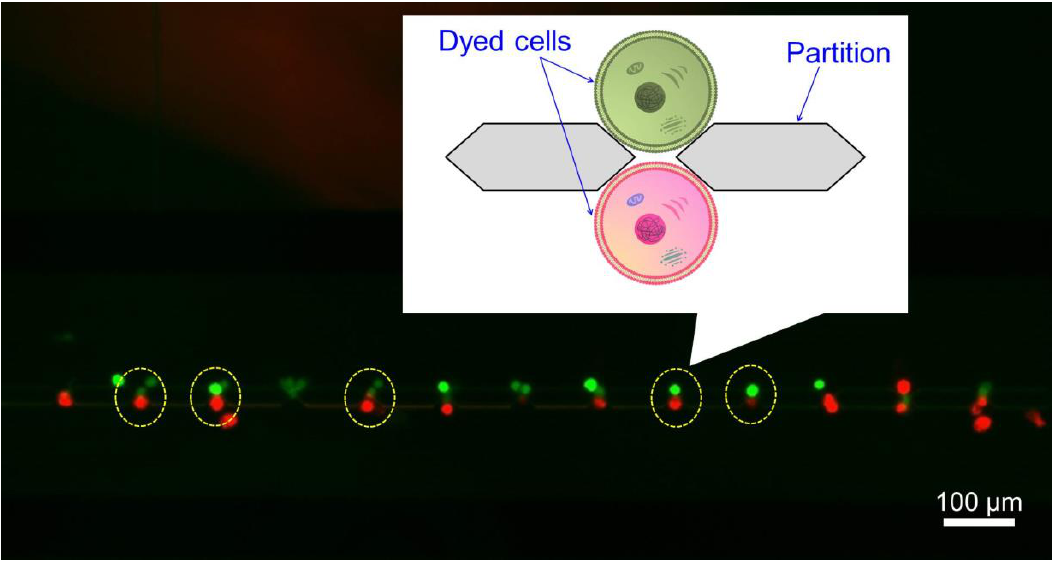
Figure 5. Fluorescent image of pairs of green and red dyed cells. Pairs with different colors were formed at the gaps between the partitions.